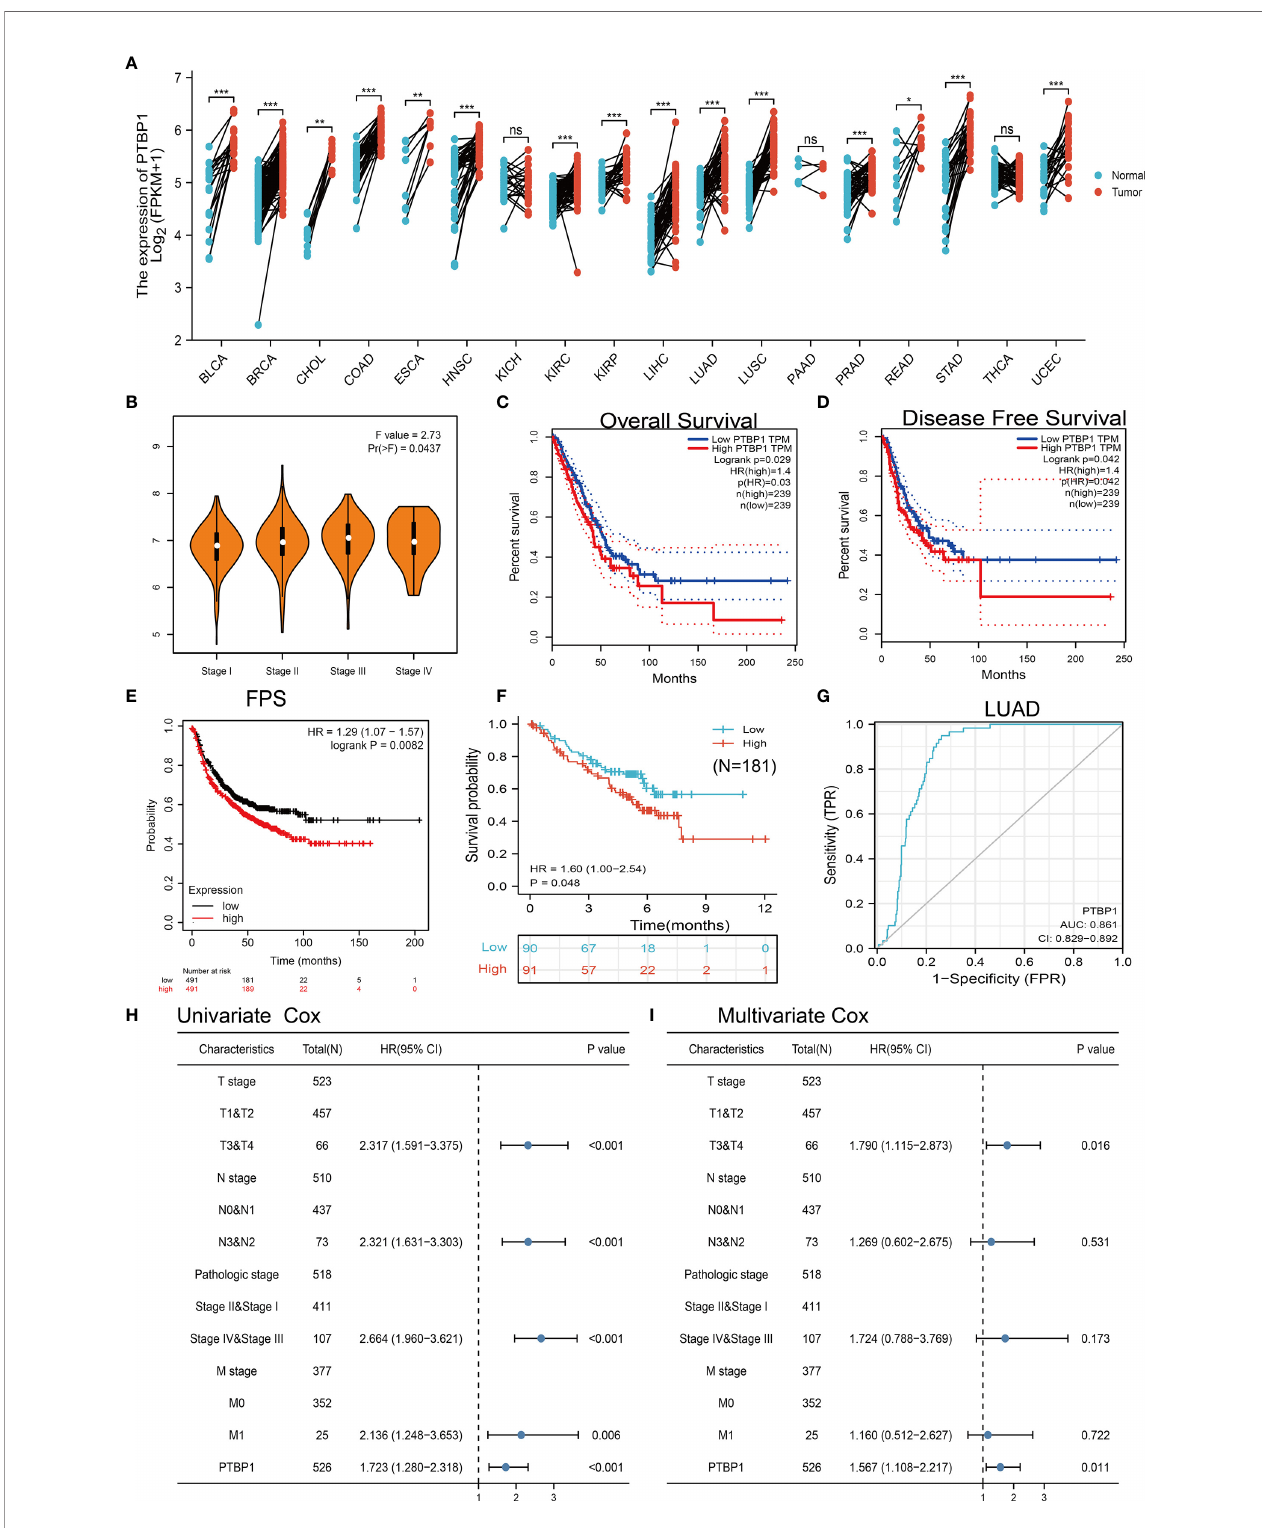
FIGURE 8 | PTBP1 was highly expressed in LUAD. (A) The expression of PTBP1 in pan-cancer. (B) Analysis of the tumor stage for PTBP1 in TCGA-LUAD analysis by using the GEPIA database. (C – F) Analysis of the overall survival, disease-free survival, and progress-free survival for PTBP1 in TCGA-LUAD and clinical sample. (G) ROC curve analyses and AUC values for miRNA-195-5p in TCGA-LUAD dataset. (H, I) Univariate and multivariate Cox regression analyses were performed to determine PTBP1 as an independent prognostic factor in the TCGA LUAD dataset. *P<0.05; **P<0.01; ***P<0.001; NS, p >